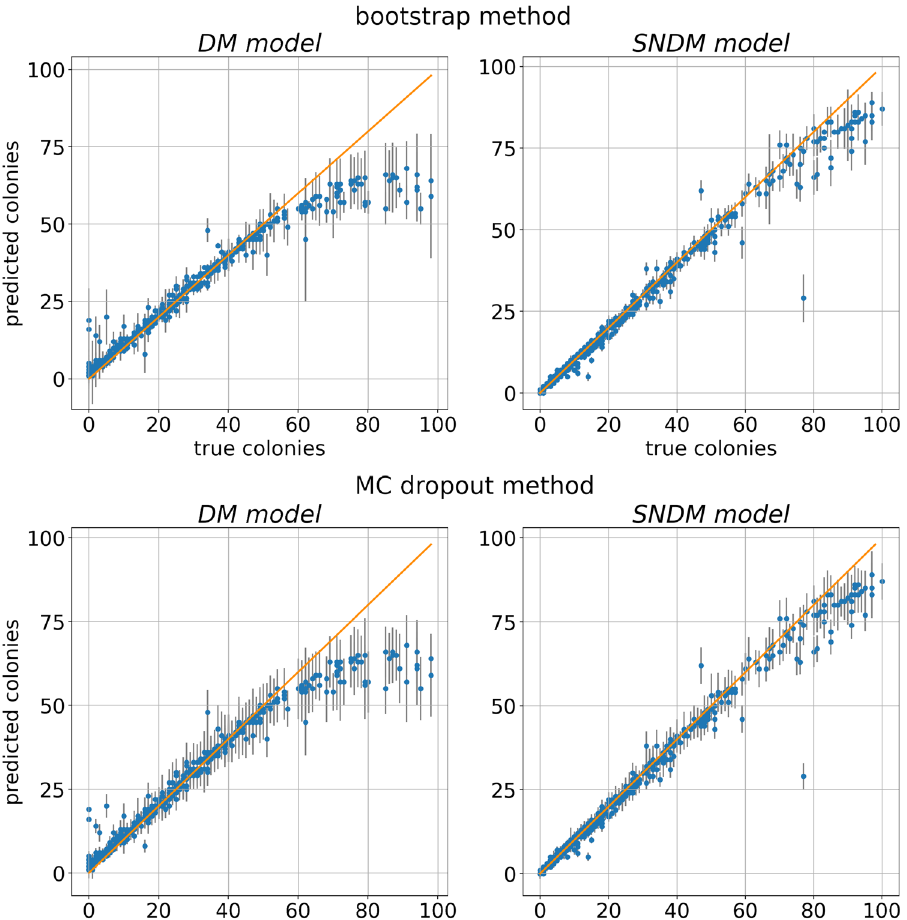
Figure 4. Dependence of the predicted number of colonies on ground truth for the test data set within the DM model (right), and self-normalized DM model (left). Note that for ideal detection every blue dot representing a single Petri dish image should lay on the y = x orange line. Uncertainties, denoted by black bars, in the bootstrap and MC dropout approaches are given in top and bottom rows, respectively.